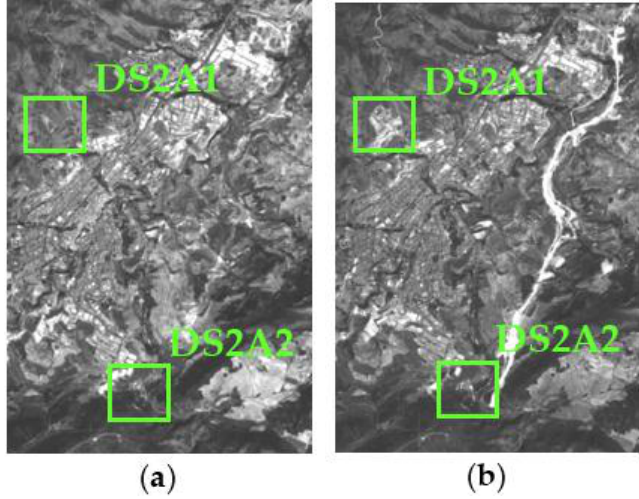
Figure 8. Data set 2 (DS2) with D2SA1 and DS2A2 highlighted subsets, radiometrically normalized images: ( a ) SPOT5 14 August 2005 reference image (master); ( b ) SPOT5 10 August 2008 normalized image (slave).